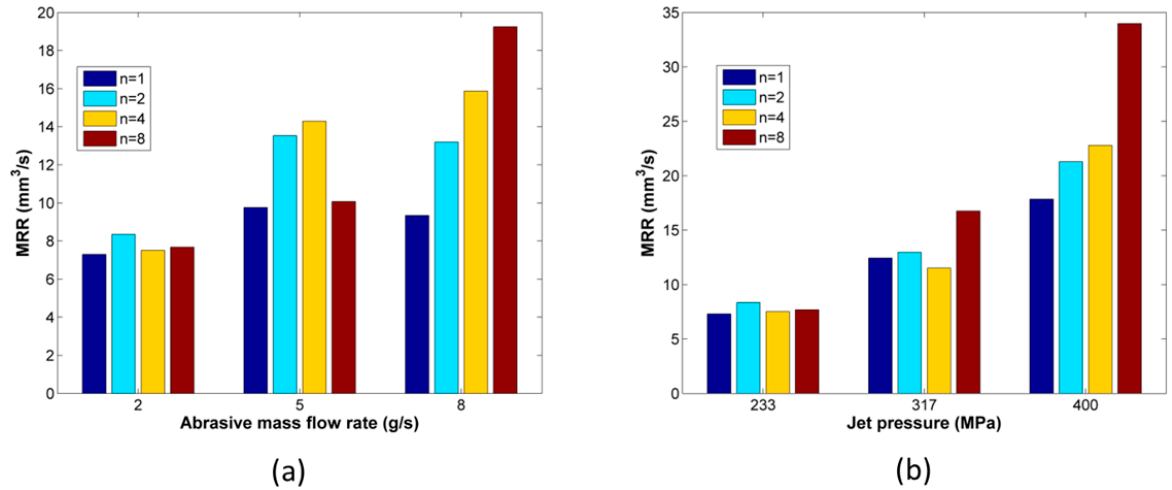
Figure 9. Variation of the mean Material Removal Rate (MRR) for increasing number of passes in respect to the ( a ) abrasive mass flow rate and ( b ) jet pressure.